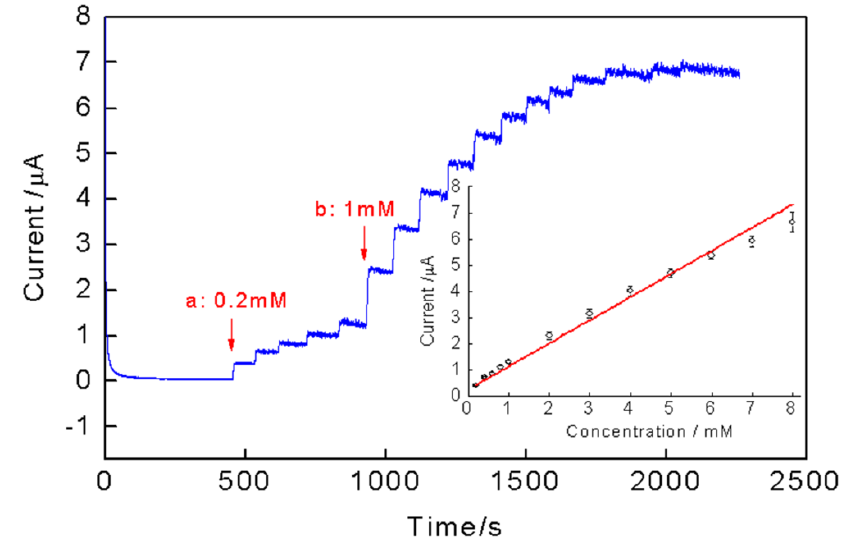
Figure 7. Typical current-time curve recorded at a PPy-RGO-(AuNPs-GOD) 4 /GCE during the addition of different concentration glucose (0.2 mM–13 mM) at a potential of 0.5 V versus SCE. The arrows “a” and “b” indicated each increased glucose concentration is 0.2 mM and 1 mM, respectively. Inset: the calibration curve of the electrode with glucose concentration ranged from 0.2 mM to 8 mM. Error bar = standard deviation (n = 5).